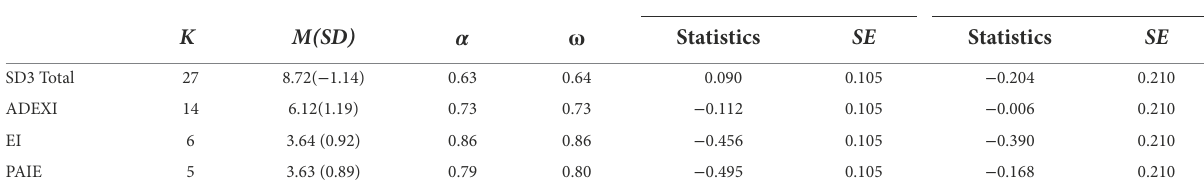
TABLE 2 Descriptive statistics and reliability estimates for the study measures. Scales